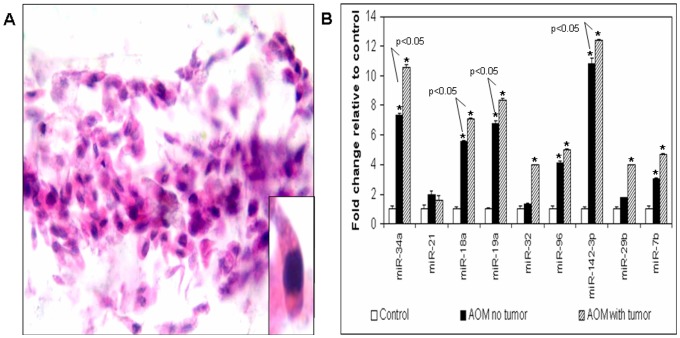
A: Hematoxylin and Eosin (H&E) staining of the fecal colonocytes isolated from rat stool.
B: Differentially expressed miRNAs in the fecal colonocytes obtained from tumor bearing and tumor non-bearing AOM rats. *: p<0.05. Specific p values are given in which AOM rats without tumors are compared to AOM rats with tumors.